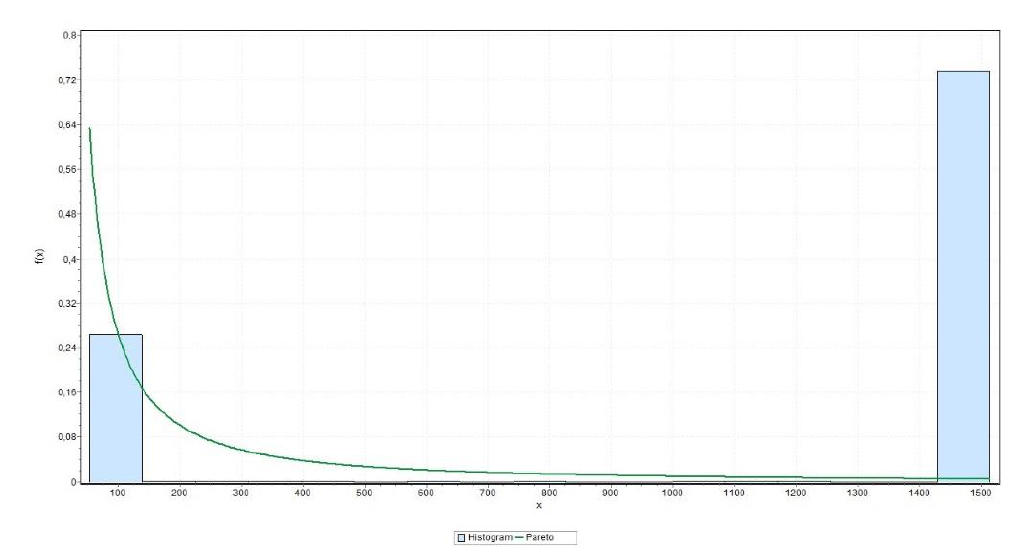
Figure 5. Pareto distribution of the lengths of the packets, the value of the parameters: α = 0.39, β = 54 After the calculation according to the above algorithm, the average waiting time of the packet was equal to t = 42.6. cp